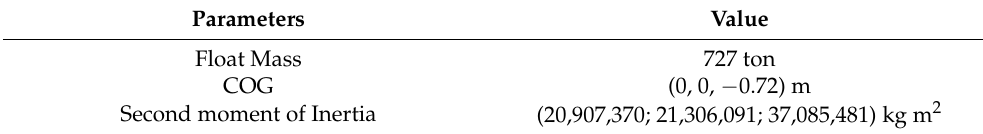
Figure 1. RM3 1:1 scale illustration [36]. Table 2. WEC mass properties